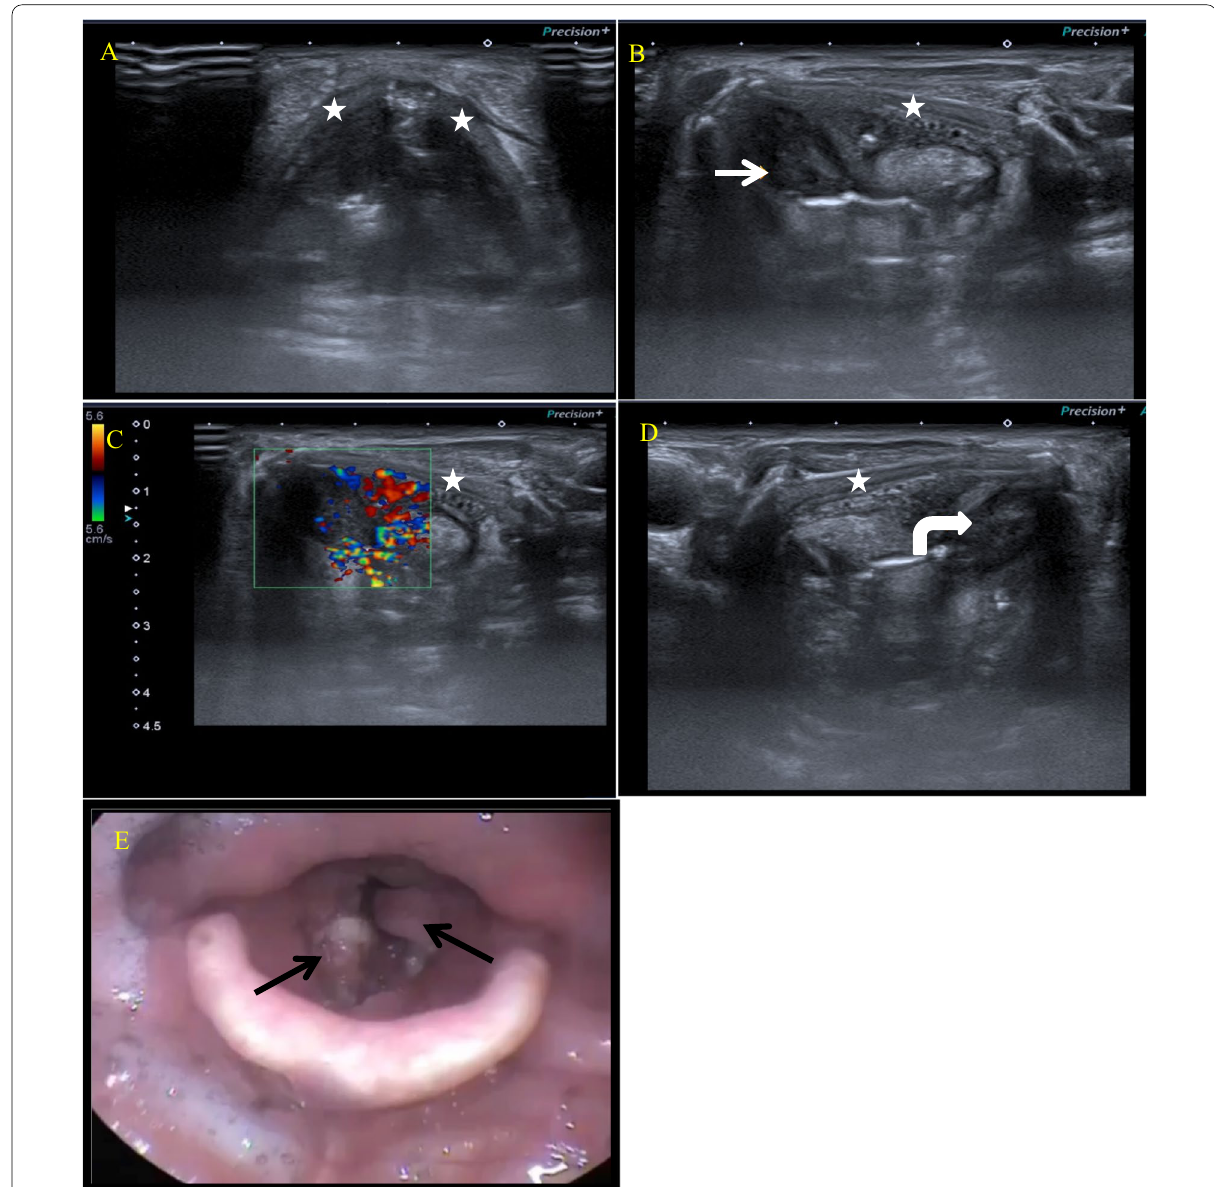
Fig. 5 A 68-year-old heavy smoker, male patient presented with hoarseness of voice and stridor. A Laryngeal ultrasound anterior axial view shows the anatomical landmarks along the level of the true vocal cord with thyroid cartilage (marked by a star). B Laryngeal US, left lateral axial view, shows left glottic and supraglottic mass lesion (arrow) with ill-definition of the posterior aspect of the left thyroid lamina (marked by a star) near the midline, denoting erosion/invasion. C Colored Doppler assessment shows internal hypervascularity of the mass lesion. D Laryngeal US, right lateral axial view, shows right glottic and supraglottic mass lesion (curved arrow). E Flexible laryngoscopy of the same patient shows bilateral glottic and supraglottic mass lesions (black arrows). The anterior is at the bottom of this